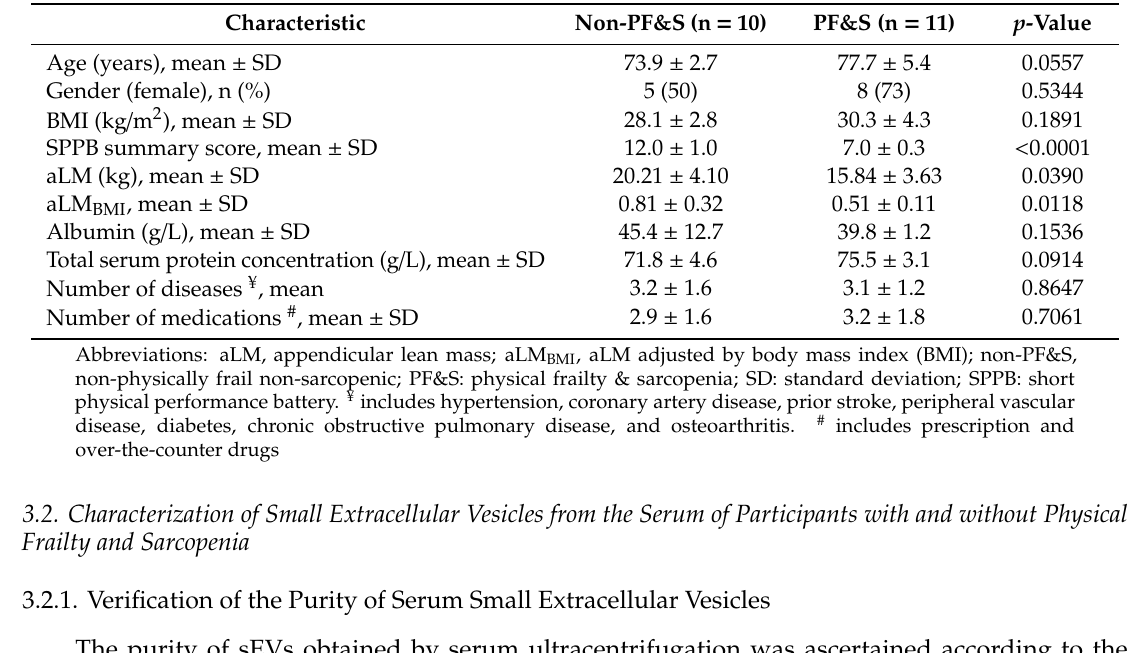
Table 2. Participant characteristics according to the presence of physical frailty and